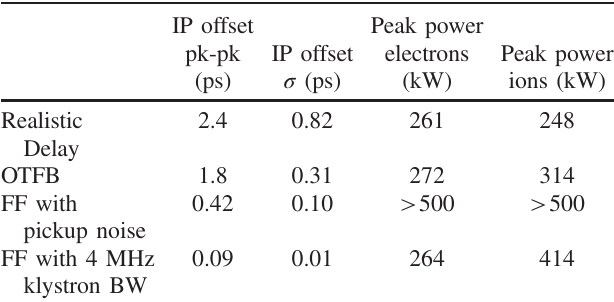
TABLE II. IP offset and klystron power for various LLRF configurations. Direct loop is on for all four cases. FF is off for the OTFB case. OTFB is off for the FF cases.